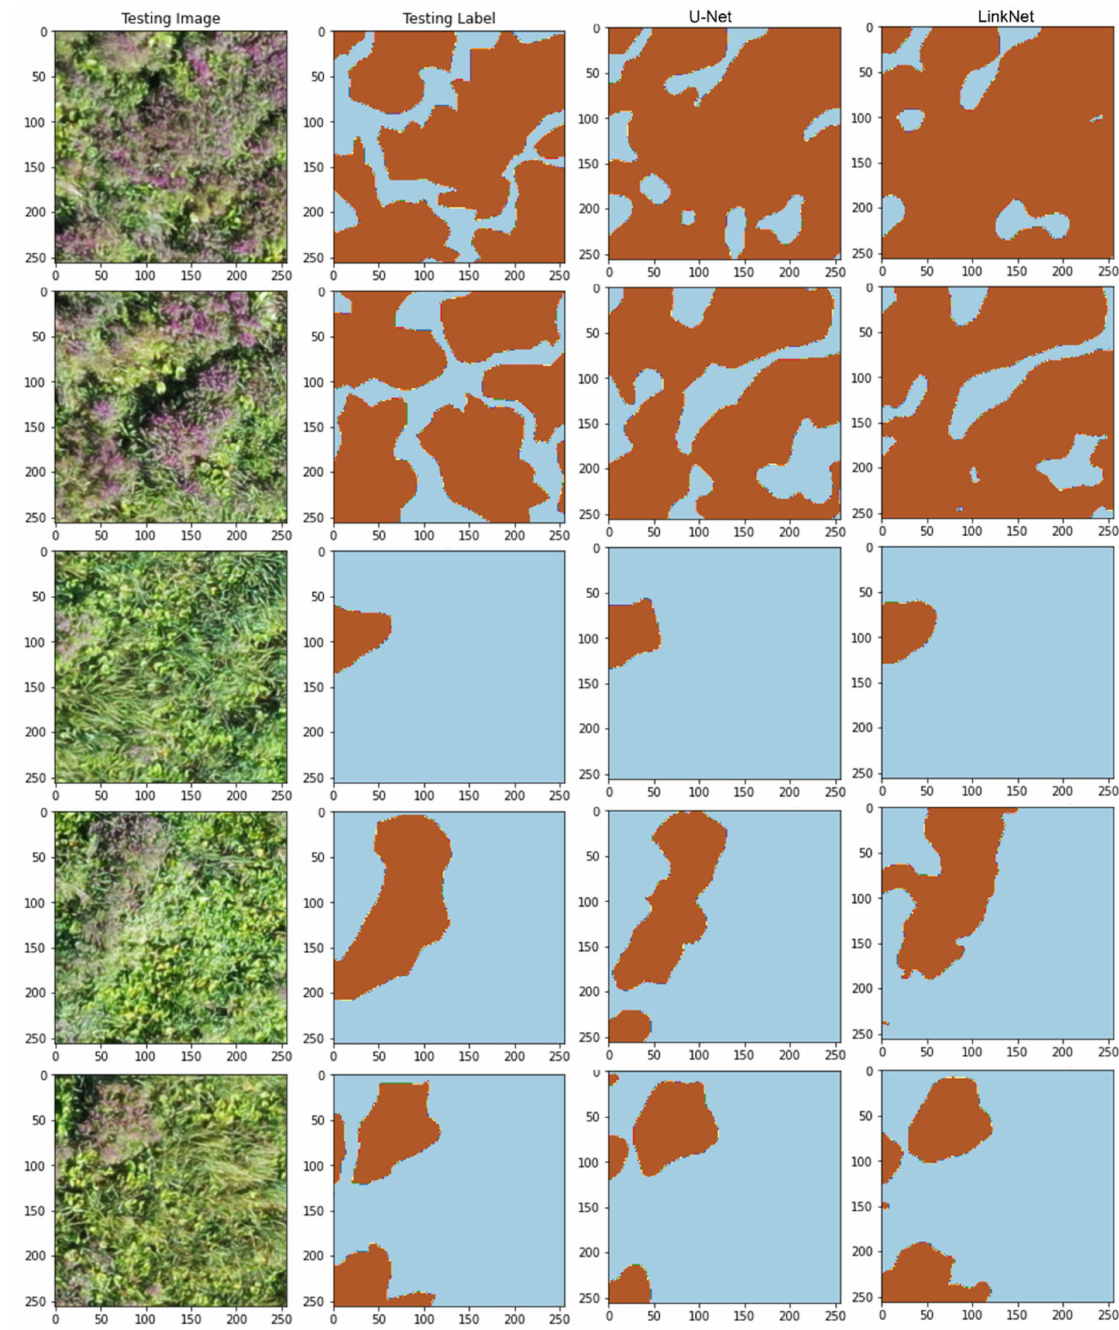
Figure 6. Selected predicted images from the U-Net and LinkNet models for different image subsets with their corresponding binary masks (ground truth) and image chips. The brown color represents the predicted purple loosestrife patches by the model and the blue color represents the background